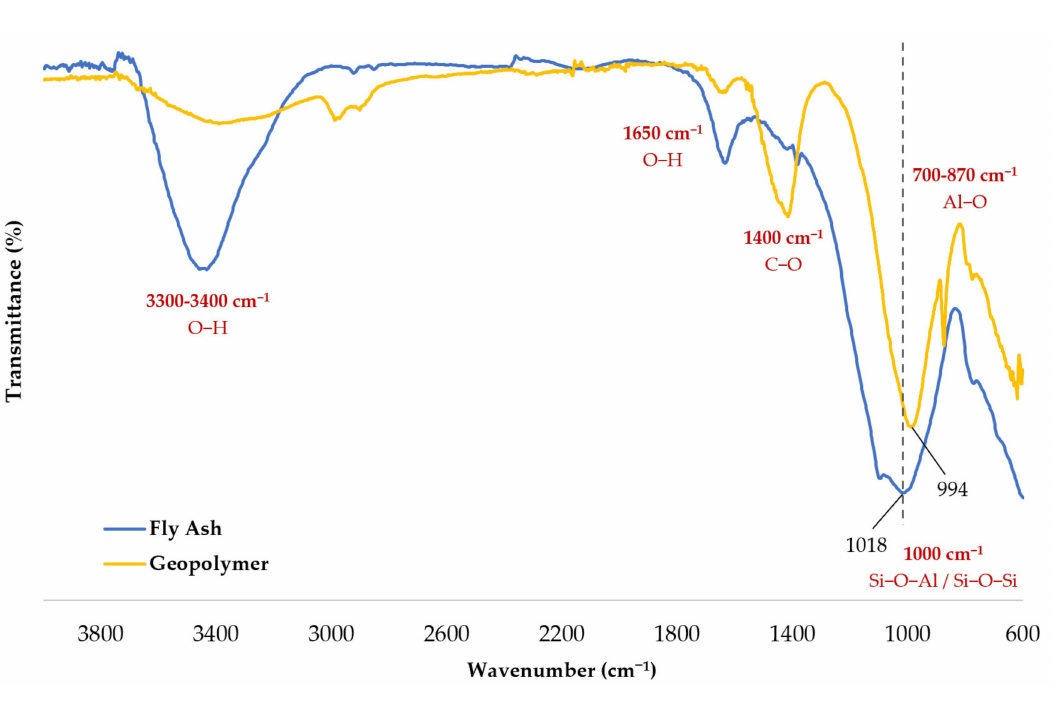
Figure 7. FTIR spectrum for the fly ash and for a control